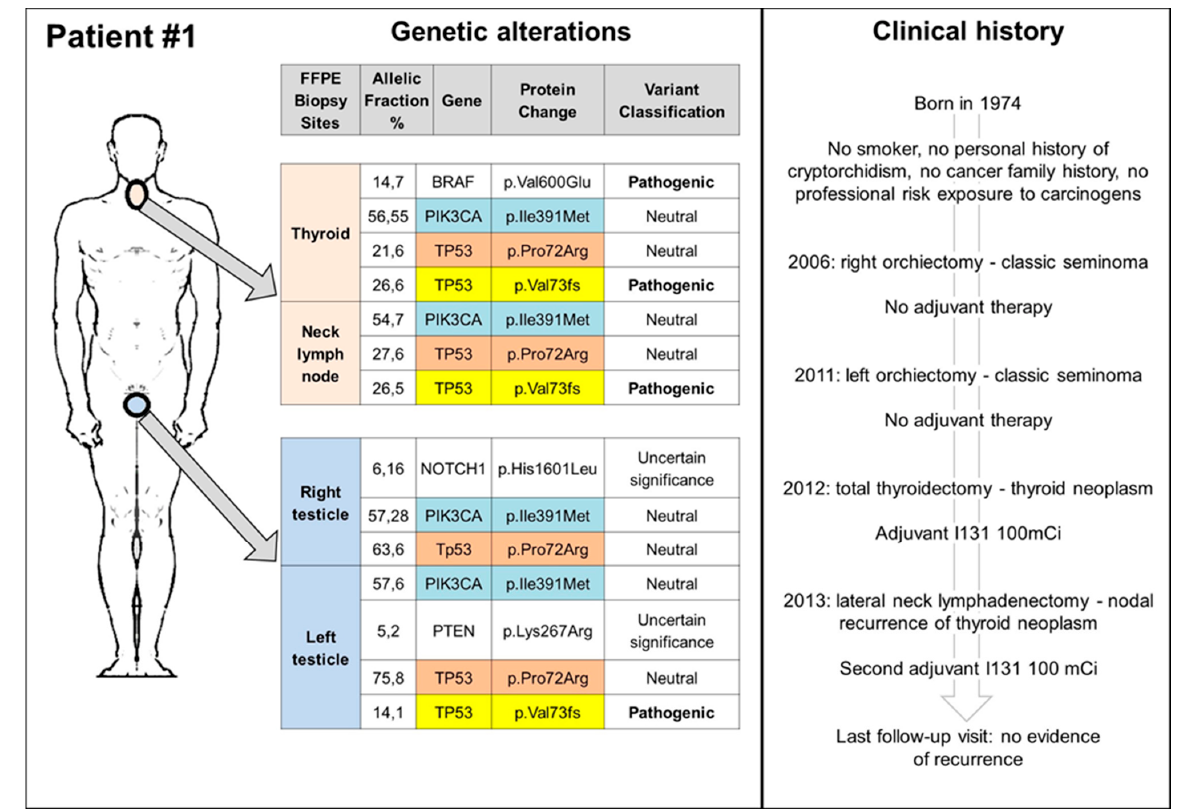
Figure 2. Clinical history and somatic genetic alterations of patient 1. FFPE: formalin-fixed paraffin-embedded.